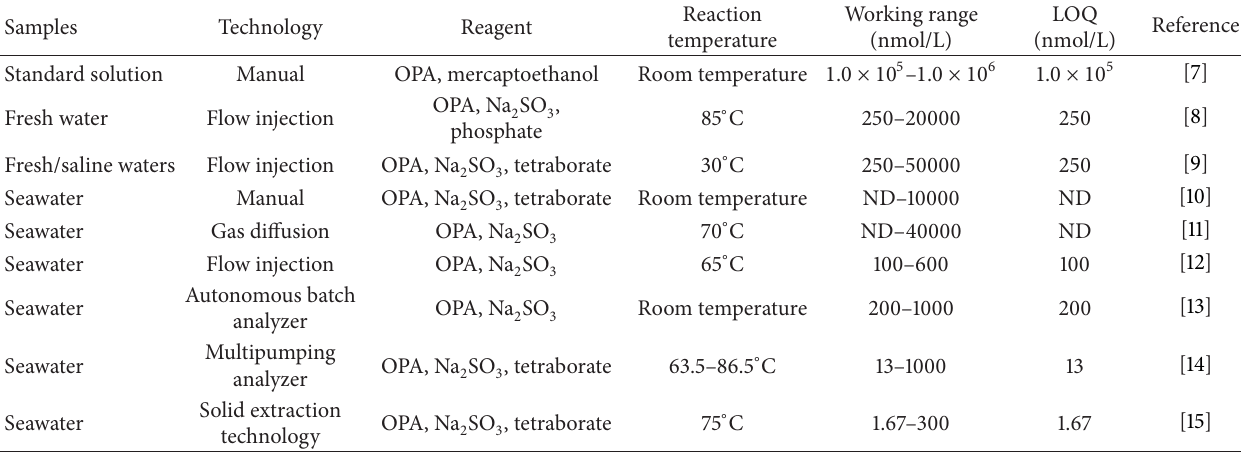
Table 1: The main analytical parameters of the typical reported OPA